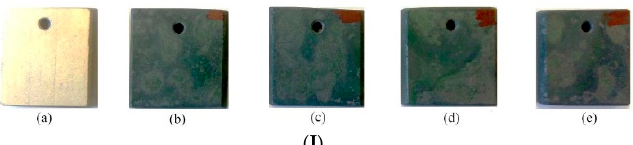
Figure A2. Photographs of the samples ( A ) 316-Bare, ( B ) 316-A, ( C ) 316-A-Sn, ( D ) 316-A-Z, ( E ) 316-Cr, ( F ) CS-Bare, ( G ) CS-A, ( H ) CS-A-Sn, ( I ) CS-A-Z, and ( J ) CS-Cr: ( a ) before corrosion testing; ( b ) after 24 h; ( c ) after 48 h; ( d ) after 96 h; and ( e ) after 168 h of exposure in high-temperature (at 600 °C) corrosive environment.